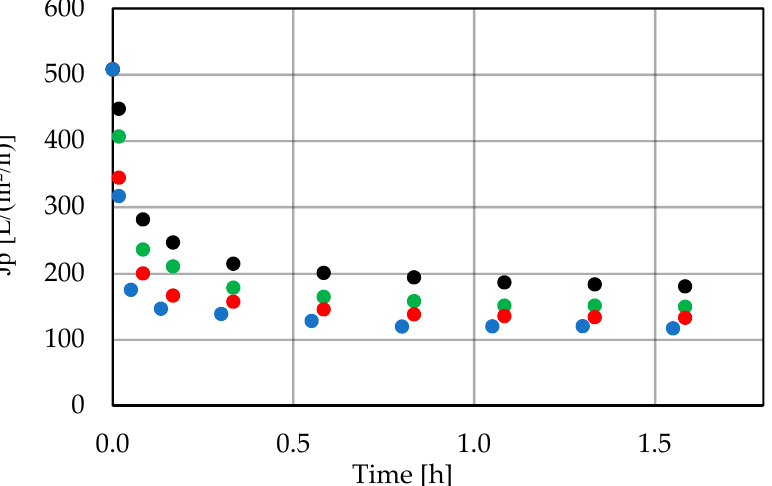
Figure 3. Change in permeate flux during low-pressure filtration for the PCI 20 kDa membrane (T = 25 °C, w =4 m/s, Δ P = 0.2 MPa) using the initial feed (•) and 2 (•), 4 (•), and 6 (•) times concentrated feeds. Points represent the average of five measurements.